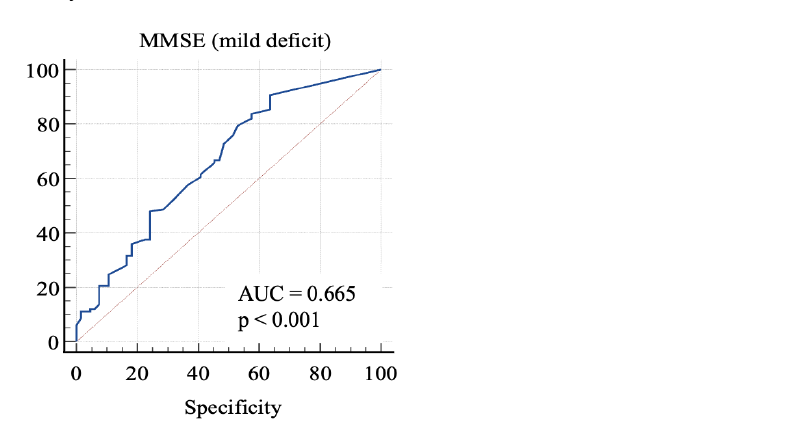
Figure 3. AUC (mild impairment). MMSE, Mini-Mental State Examination; AUC, area under the ROC curve.